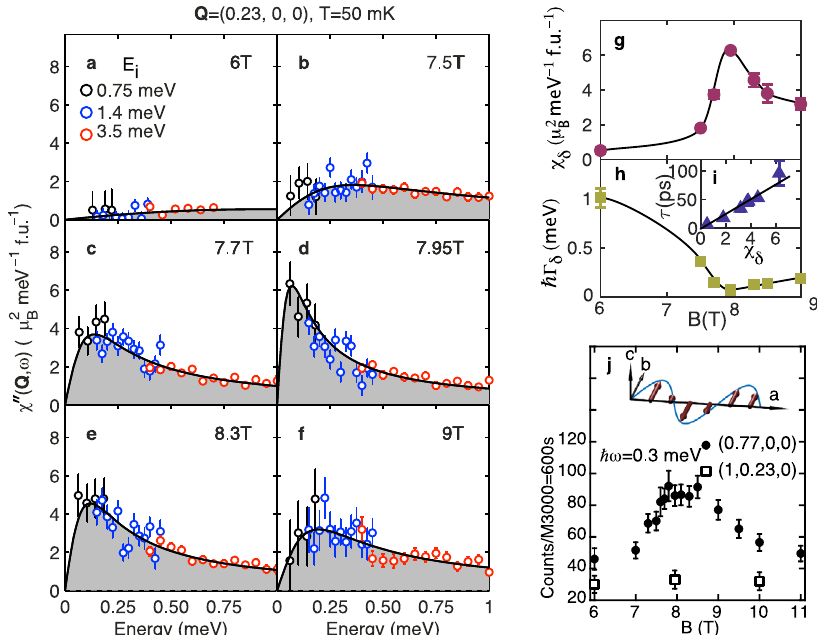
Fig. 2 The collective spin fl uctuations in Sr 3 Ru 2 O 7 measured through its quantum critical point. a – f Energy-dependent spectra of the magnetic response function χ ″ ( Q , ω ) for Q = Q δ measured for magnetic fi elds through the critical fi eld. The magnetic response has a Lorentzian form (solid lines) and softens (strengthens at the lowest energies) for the critical fi eld B c = 7.95 T. The data have been integrated over − 0.5 < ℓ < 0.5. Colour of points indicates the incident neutron energy ( E i ), also in Fig. 1. g The wavevector-dependent susceptibility χ δ is peaked at B c . h The spin relaxation rate Γ δ is minimum at B c and the inset shows that the relaxation time τ = 1/ Γ δ ∝ χ δ . j The spin fl uctuations are seen at Q = (1 − δ , 0, 0) and not at (1, δ , 0) implying that they have transverse polarisation as illustrated for the SDW propagating along the a -axis.